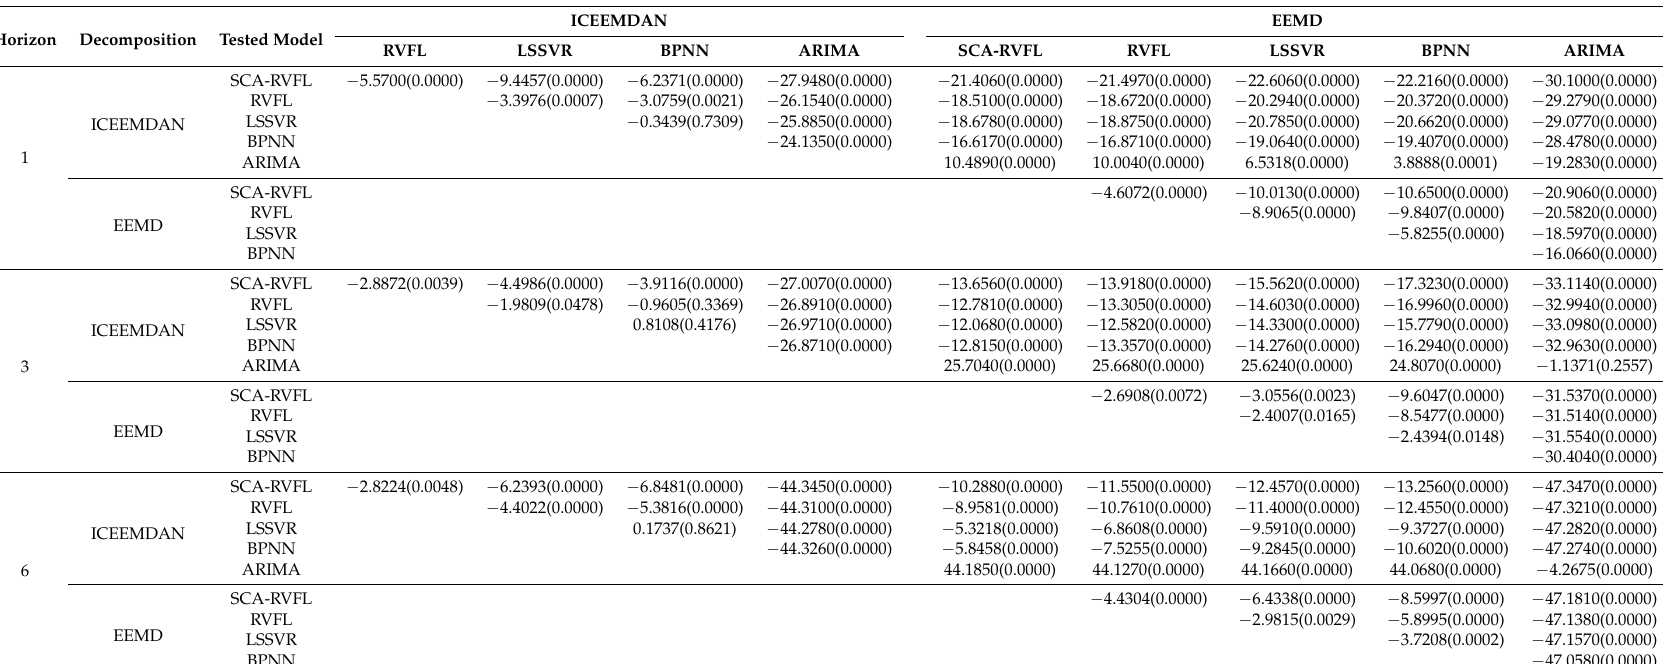
Table 5. Results of Diebold-Mariano (DM) test of ensemble